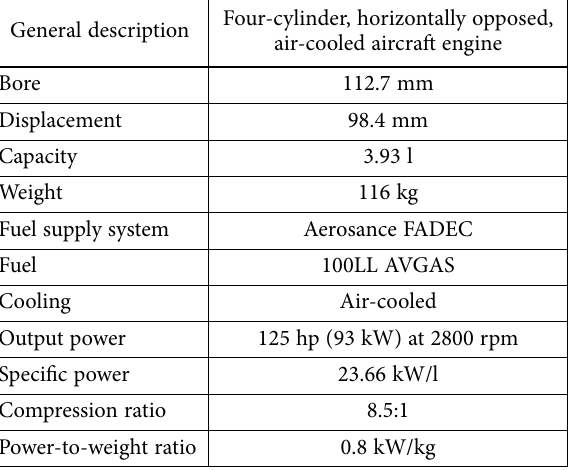
Table 1. Continental Motors IOF-240-B5B technical parameters (Ośrodek Kształcenia Lotniczego… 2018)